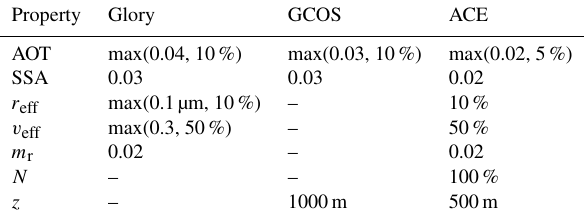
Table 1. Accuracy requirements on aerosol properties from Mishchenko et al. (2004) as used for the Glory mission, Global Climate Observing System (GCOS), and the ACE study (https://acemission.gsfc.nasa.gov/documents/ACE_Report5_ Aerosol_Science_v7.pdf, last access: 13 December 2018).